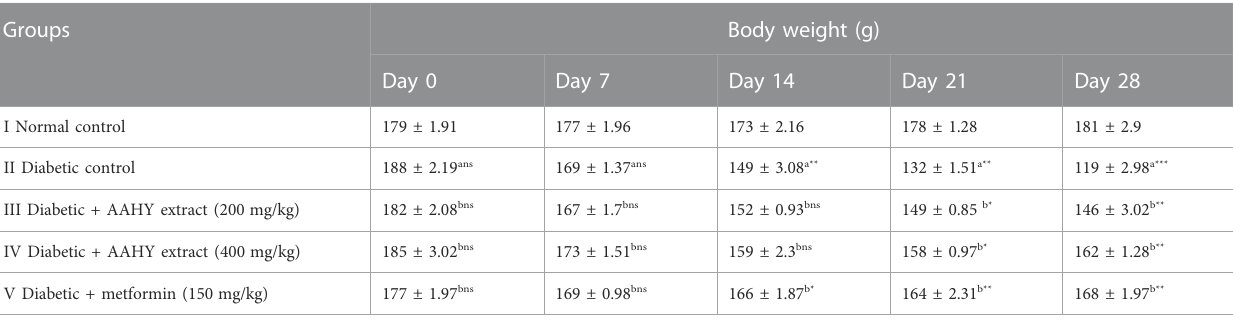
TABLE 4 Effect of the AAHY extract on the body weight of experimental rats (g).